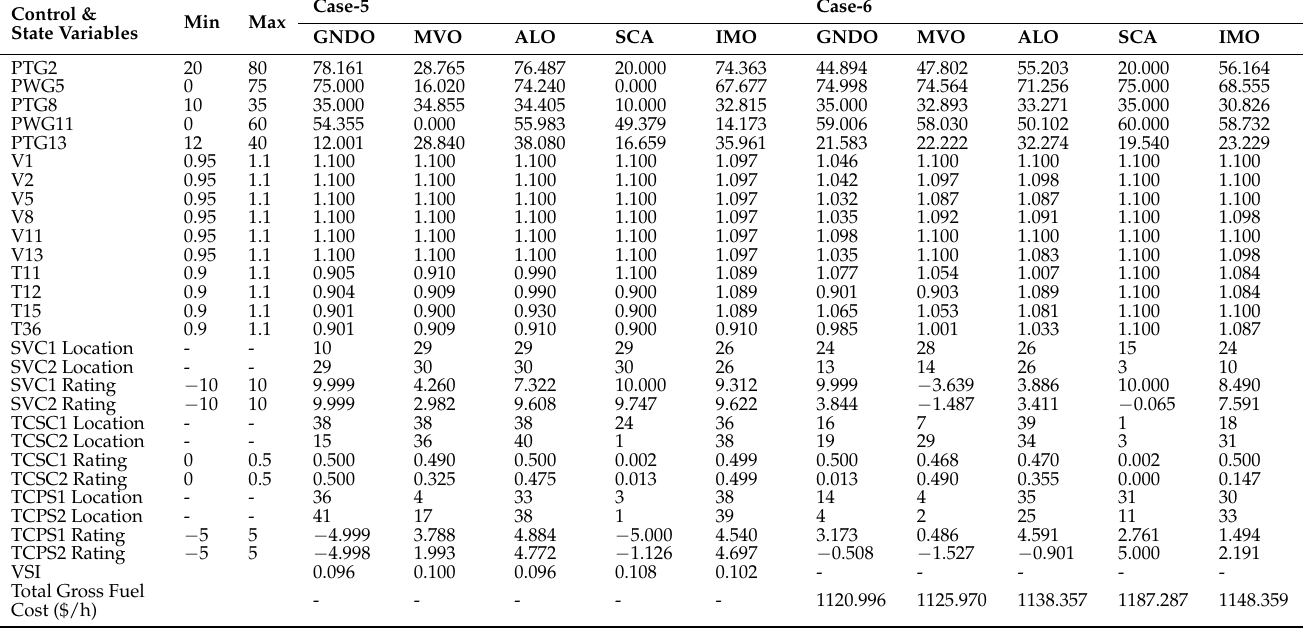
Table 11. Single objectives simulation results for case 5 and case